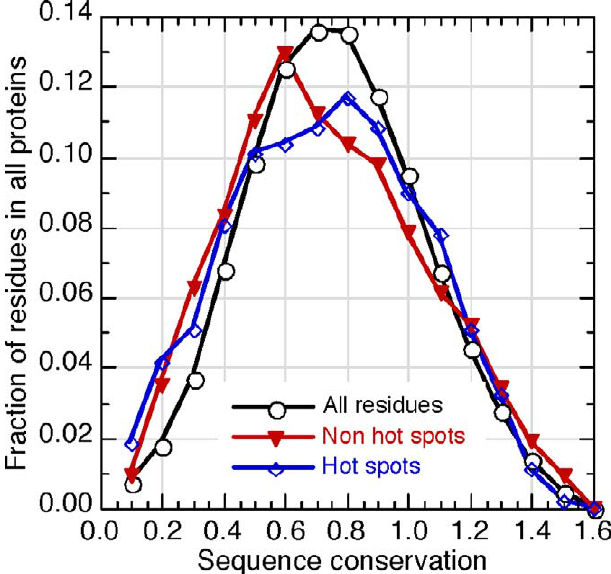
Figure 3. The Common Features of Hotspots Are Hard To Identify without Machine Learning Physicochemical, structural, and evolutionary features differentiate hotspots from other residues. However, while each of these features is crucial for the success of the prediction, a simple, linear combination of them will not suffice. The distributions of residue conservation ( x -axis, HSSP [46] conservation score) are compared between the entire sequences of the proteins in the dataset (black circles), hotspots (blue diamonds), and residues with no effect (measured by alanine scans) on protein–protein binding (red triangles). The y- axis gives the fraction of residues with a given level of conservation. The differences are marginal, but the overall effect of conservation on the prediction is